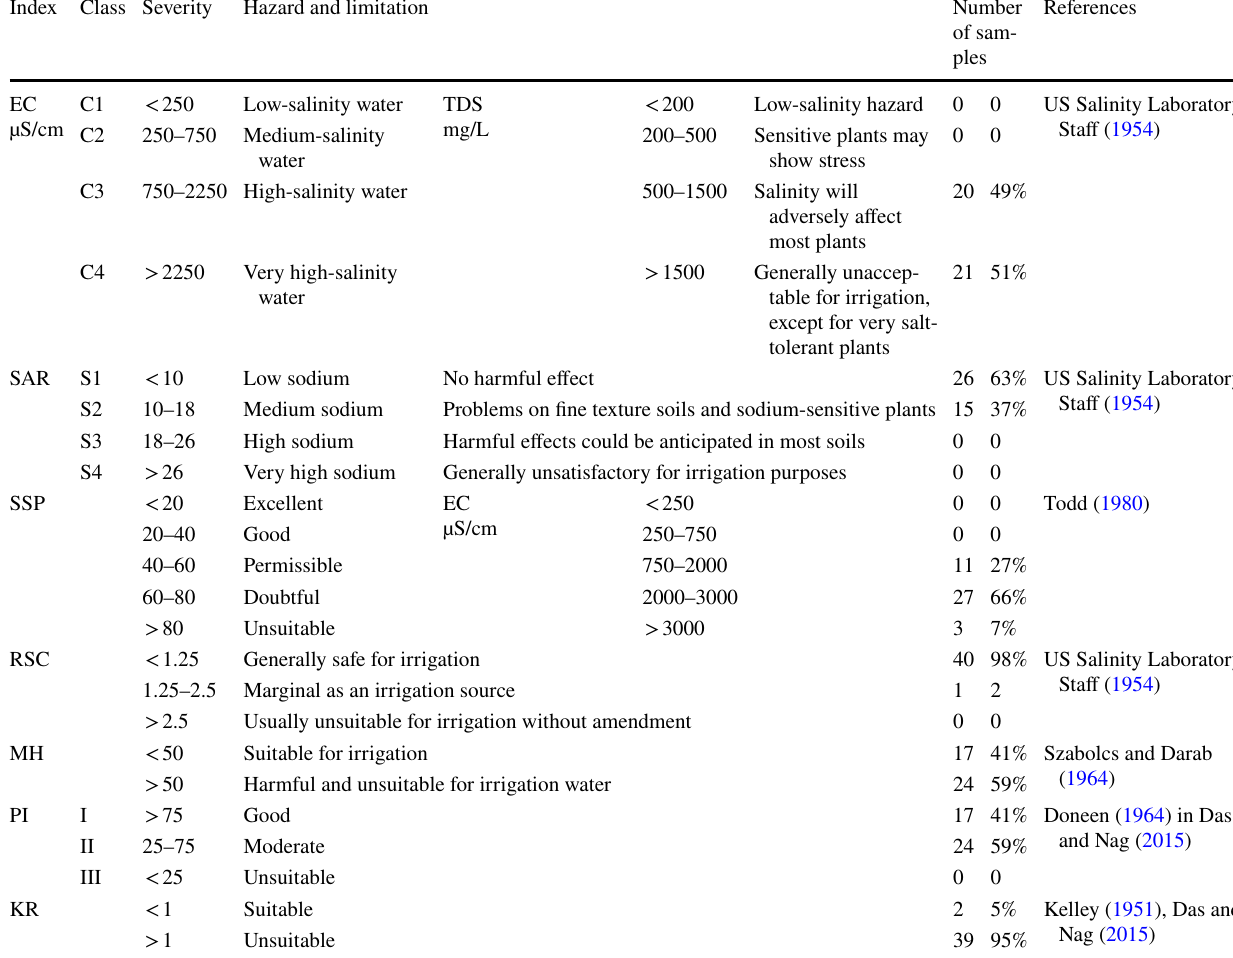
Table 7 Irrigation water quality parameters of groundwater samples in the study